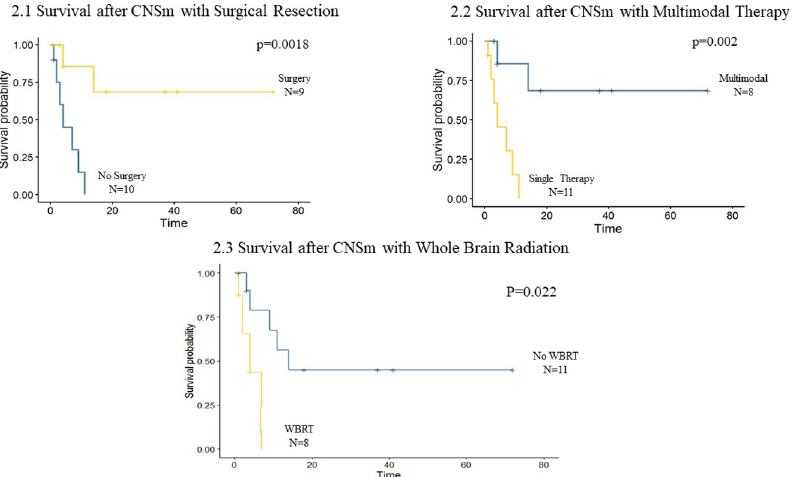
Fig 2. Survival after central nervous system metastasis based on treatment approach. Survival after central nervous system metastasis based on treatment approach in endometrial cancer patients with central nervous system metastasis. Survival time displayed in number of months . (2.1) Survival following CNS metastasis diagnosis for patients undergoing surgical resection of CNSm versus those who did not undergo surgery. (2.2) Survival following CNS metastasis diagnosis for patients undergoing multimodal therapy for treatment of CNSm compared to those who underwent single modality therapy. (2.3) Survival following CNS metastasis diagnosis for patients undergoing whole brain radiation therapy (WBRT) compared to those who did not undergo